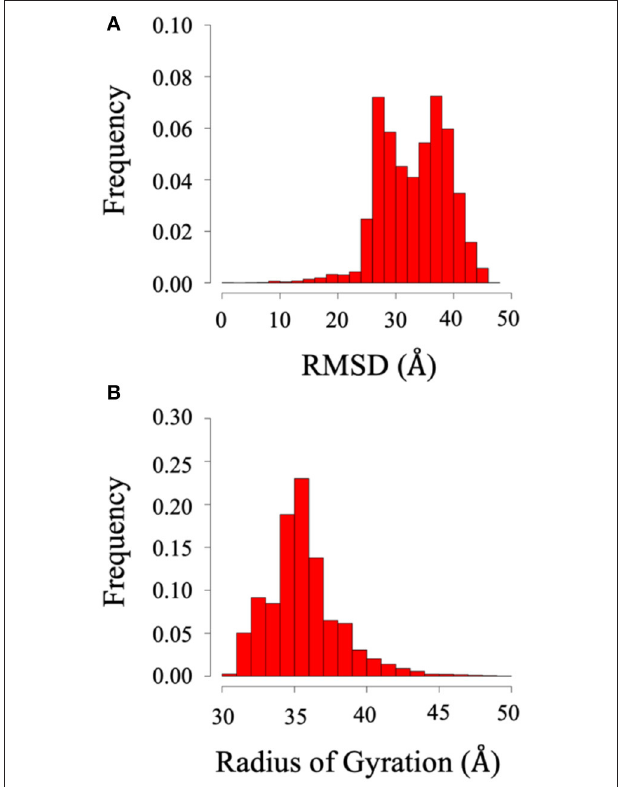
FIGURE 8 | RMSD and radius of gyration of System 2 (BAR domain with C-termini). (A) RMSD. (B) Radius of gyration. The wide range of frequency signifies the system is very dynamic.